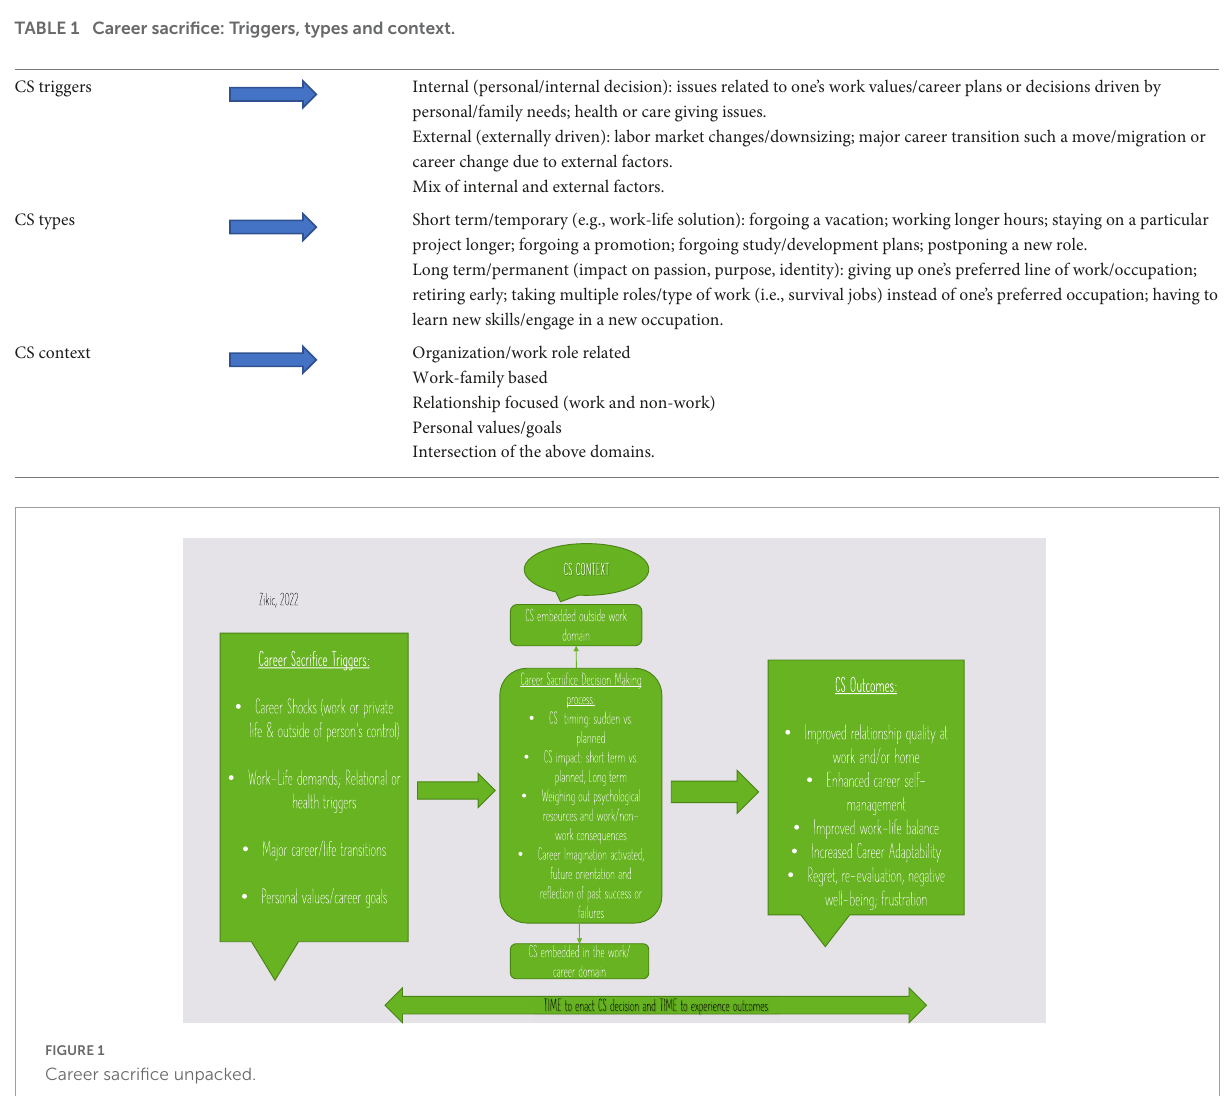
FIGURE1 Career sacrifice